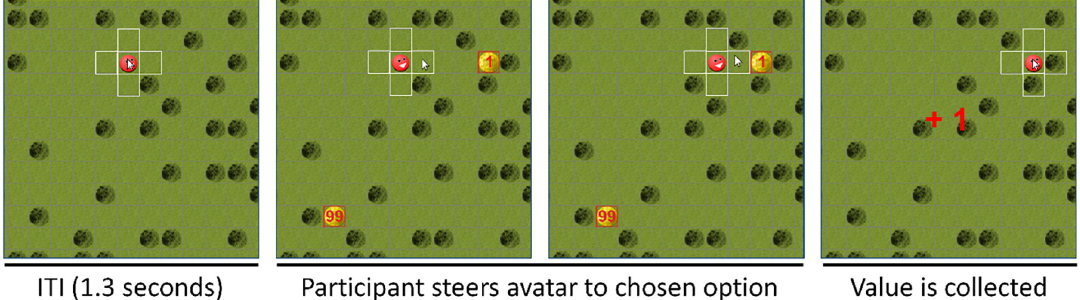
Fig 4. Sketch of one trial in the delay discounting game. During the inter-trial-interval of 1.3 seconds, the mouse cursor is locked in the avatar’s current position. After the ITI, the two options are presented as coins with values written on top in red font. Participants have to steer the avatar field-by-field to the option they want to collect. When they reach the option’s field, the option’s value is collected and the collected value is presented to indicate that the choice is completed. At all time, participants could see the remaining time within one block and the collected credits in Euro on a panel at the right side of the playing field.